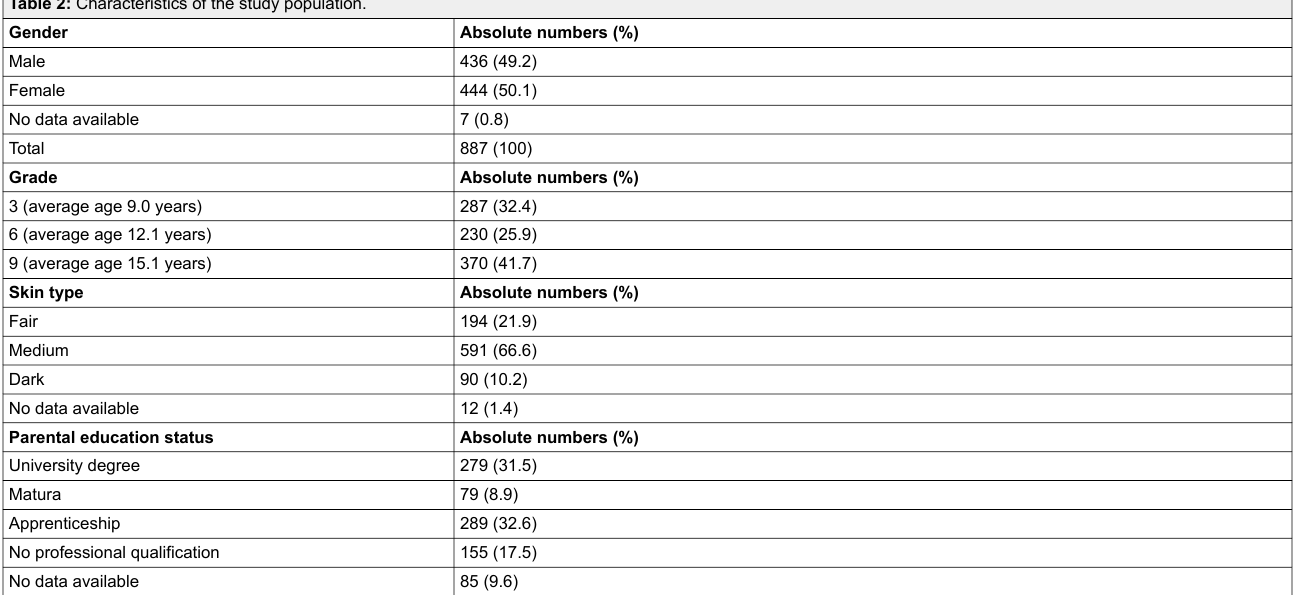
Table 2: Characteristics of the study